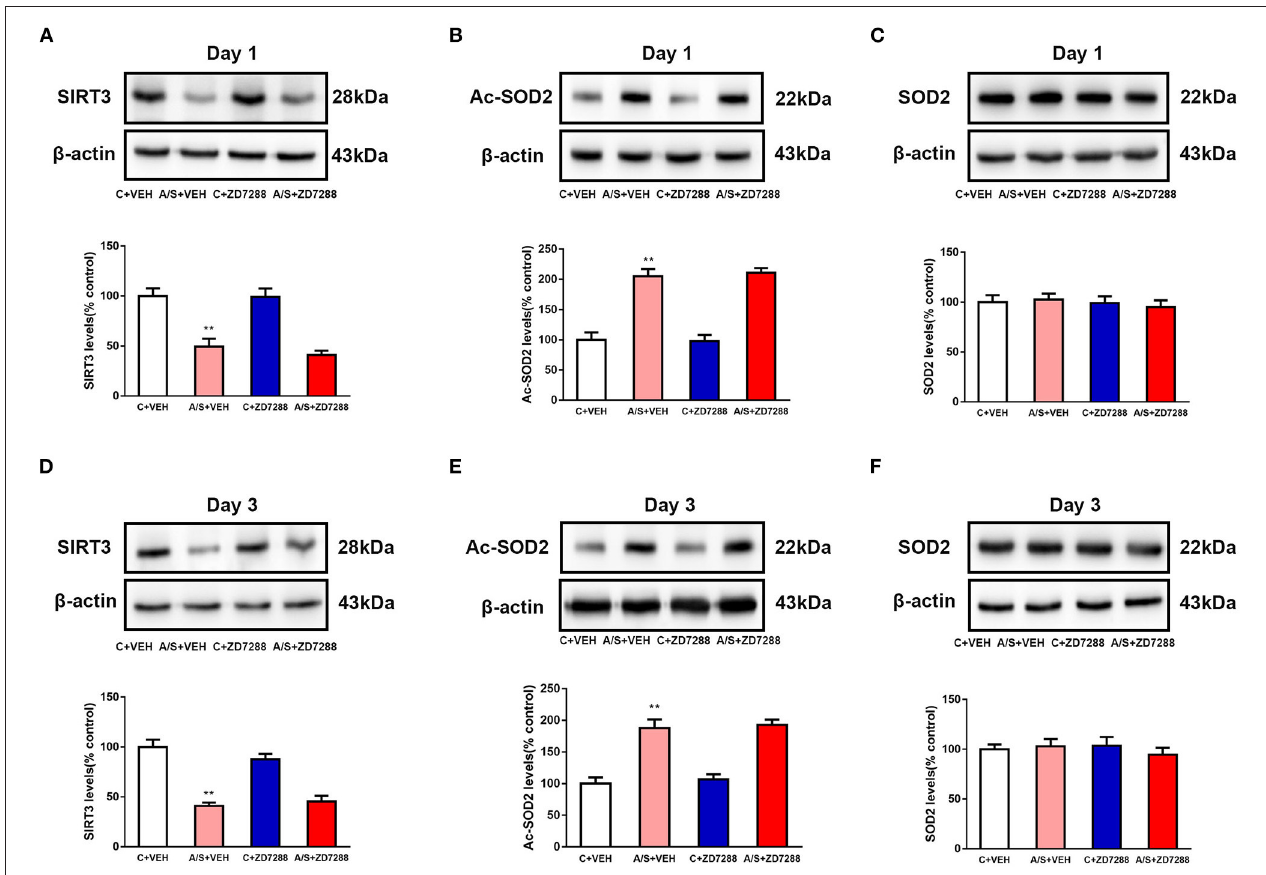
FIGURE 6 | Effect of the HCN1 inhibitor ZD7288 on SIRT3, SOD2, and Ac-SOD2 levels. (A–F) SIRT3, Ac-SOD2, and SOD2 expression among the four groups on days 1 and 3 are shown by western blotting and quantification ( n = 6 per group, ** p < 0.01). Data are presented as the means ±